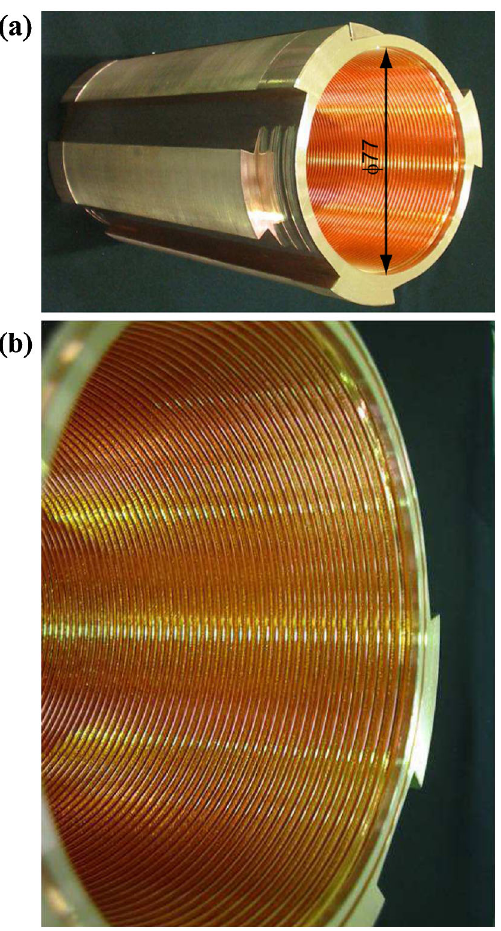
FIG. 12. (a) Grooved outer conductor of the coaxial line, made of oxygen-free copper, for the first grooved coupler, where the dimension is given in millimeters. (b) Magnification of (a).